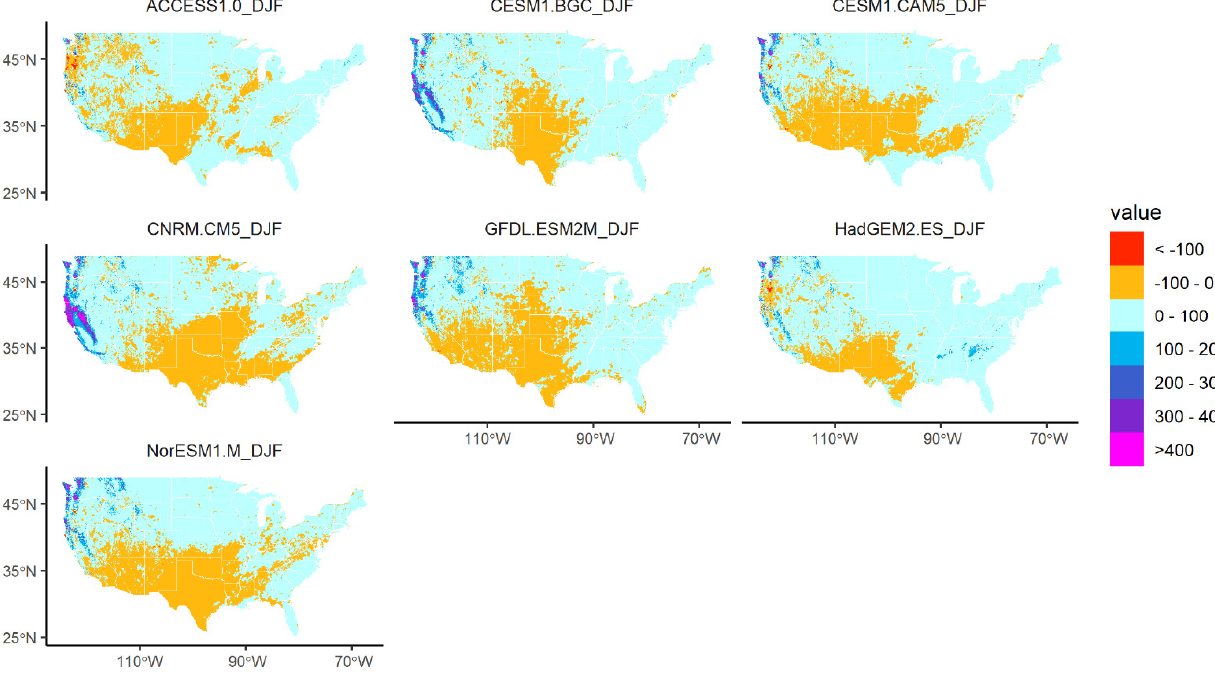
Figure A3. As Figure A2, except representing the change in winter precipitation (December through February).